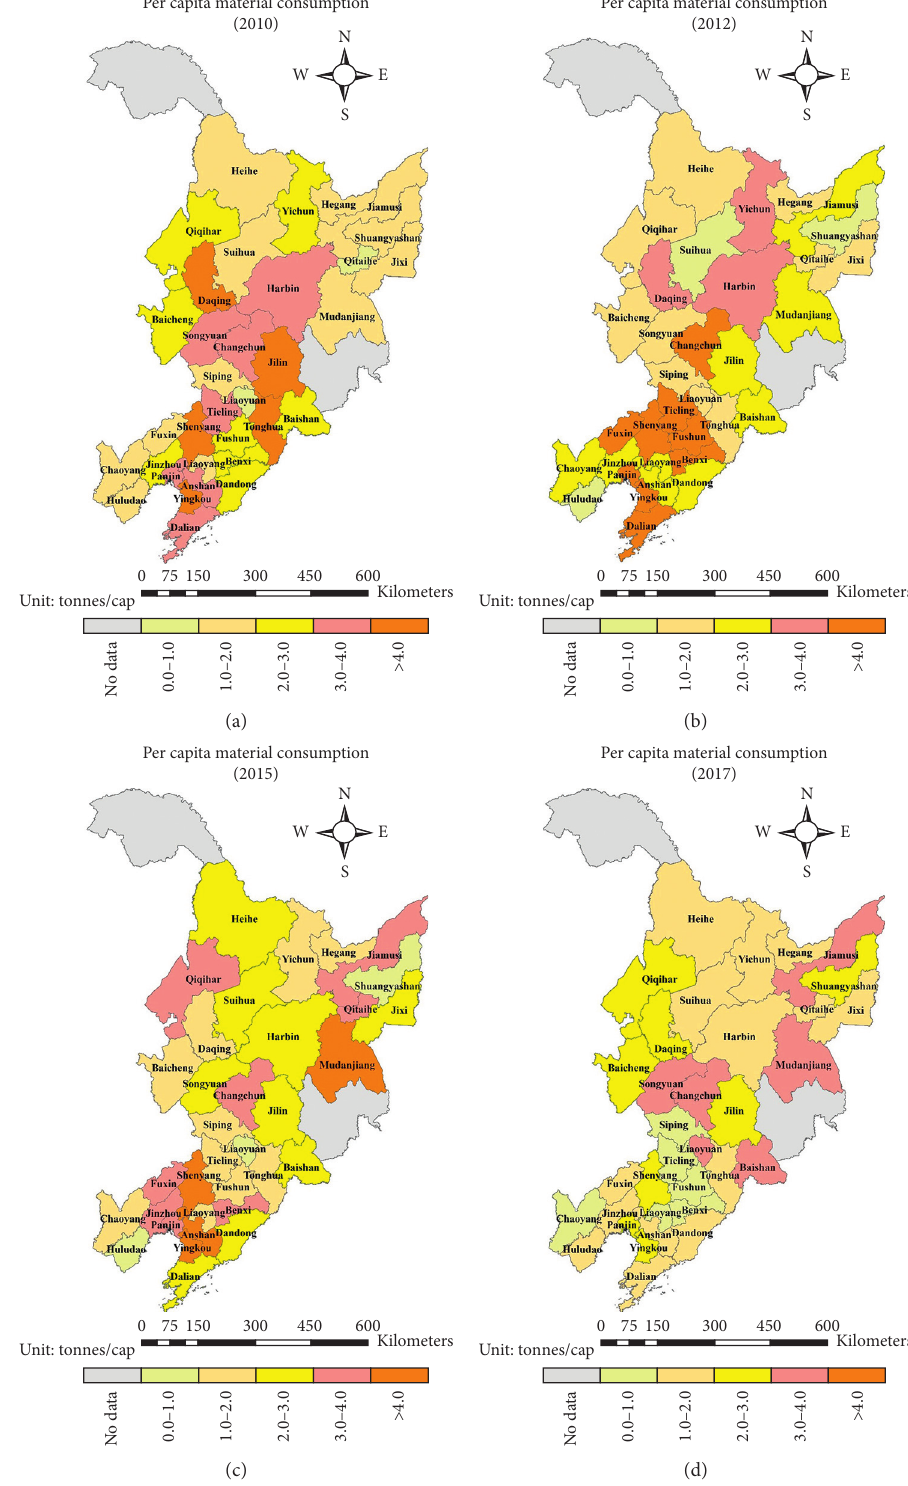
Figure 6: Spatial patterns of per capita material consumption of the infrastructure construction of 34 cities in Northeast China in 2010, 2012, 2015, and